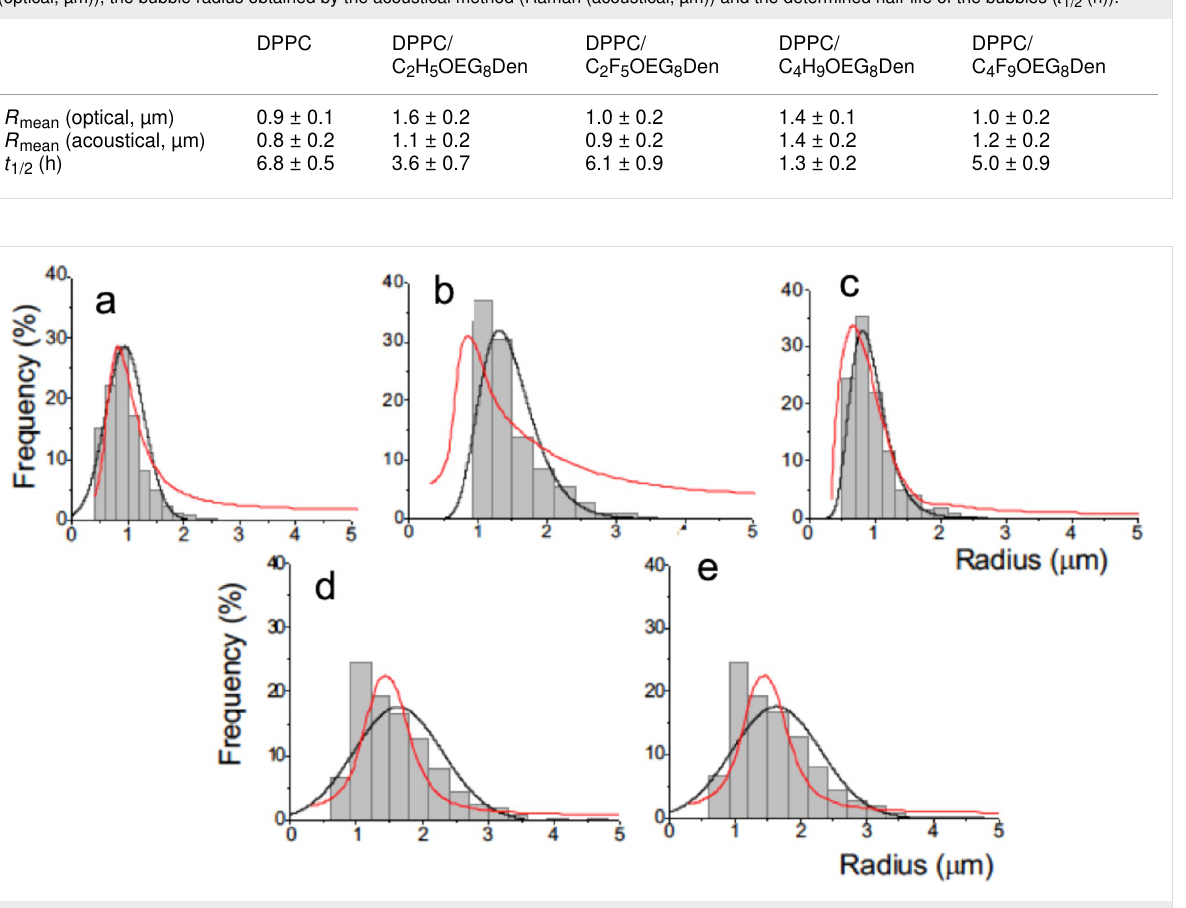
Figure 6: Size distributions of DPPC and DPPC/dendronized IONP-shelled microbubbles stabilized with F -hexane (grey line: Gaussian fit of the size histograms derived from optical microscopy; red line: distributions obtained by the acoustical method). a) DPPC alone; b–e) DPPC/ IONP@C n X 2 n +1 OEG 8 Den mixtures with b) C 2 H 5 OEG 8 Den; c) C 2 F 5 OEG 8 Den; d) C 4 H 9 OEG 8 Den, and e) C 4 F 9 OEG 8 Den. The concentration of IONPs was 0.1 mg mL − 1 ; temperature 25